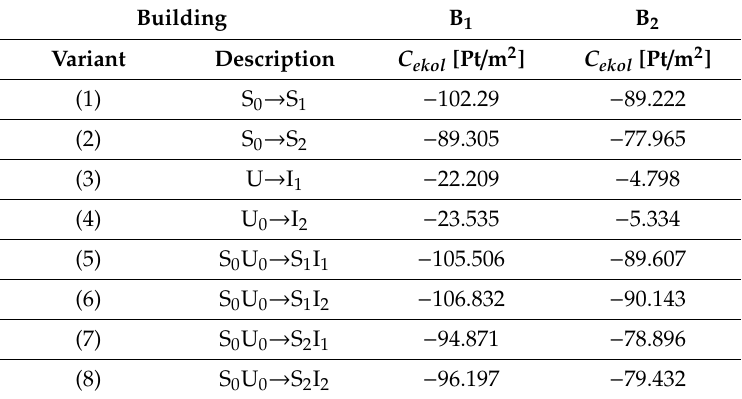
Table 7. Ecological costs of